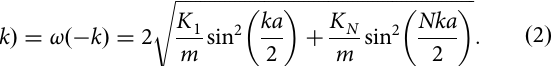
ffiffiffiffiffiffiffiffiffiffiffiffiffiffiffiffiffiffiffiffiffiffiffiffiffiffiffiffiffiffiffiffiffi p ¼ a ð K þ K phase velocity v N 2 Þ = m . For N ≥ 3 and ph 1 N = K > 1 = N , a minimum of ω ð k Þ occurs inside of the fi rst K N 1 Brillouin zone at wavenumber k (cid:4) 2 π = ð Na Þ < π = a . Example dispersion relations for N ¼ 3 and different ratios of